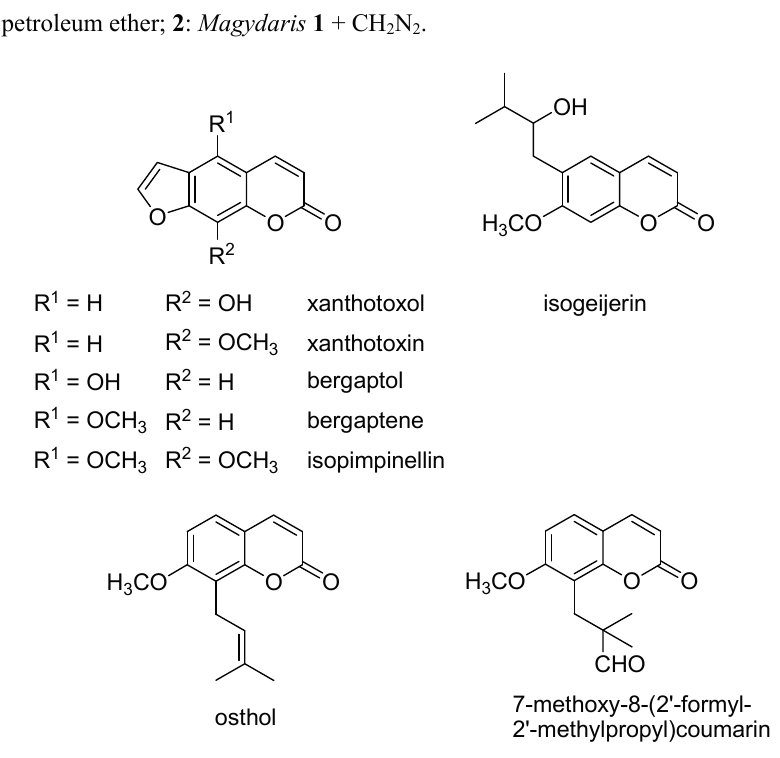
Figure 1. Structures of coumarins occurring in hexane extract of M. tomentosa flowers. In addition, 12% of the extract has been shown to be mainly constituted by saturated hydrocarbons with an odd number of carbon atoms in the chain, i.e ., nonacosane (7.2%) and hentriacontane (1.8%) that are universally distributed as cuticular waxes on the plant